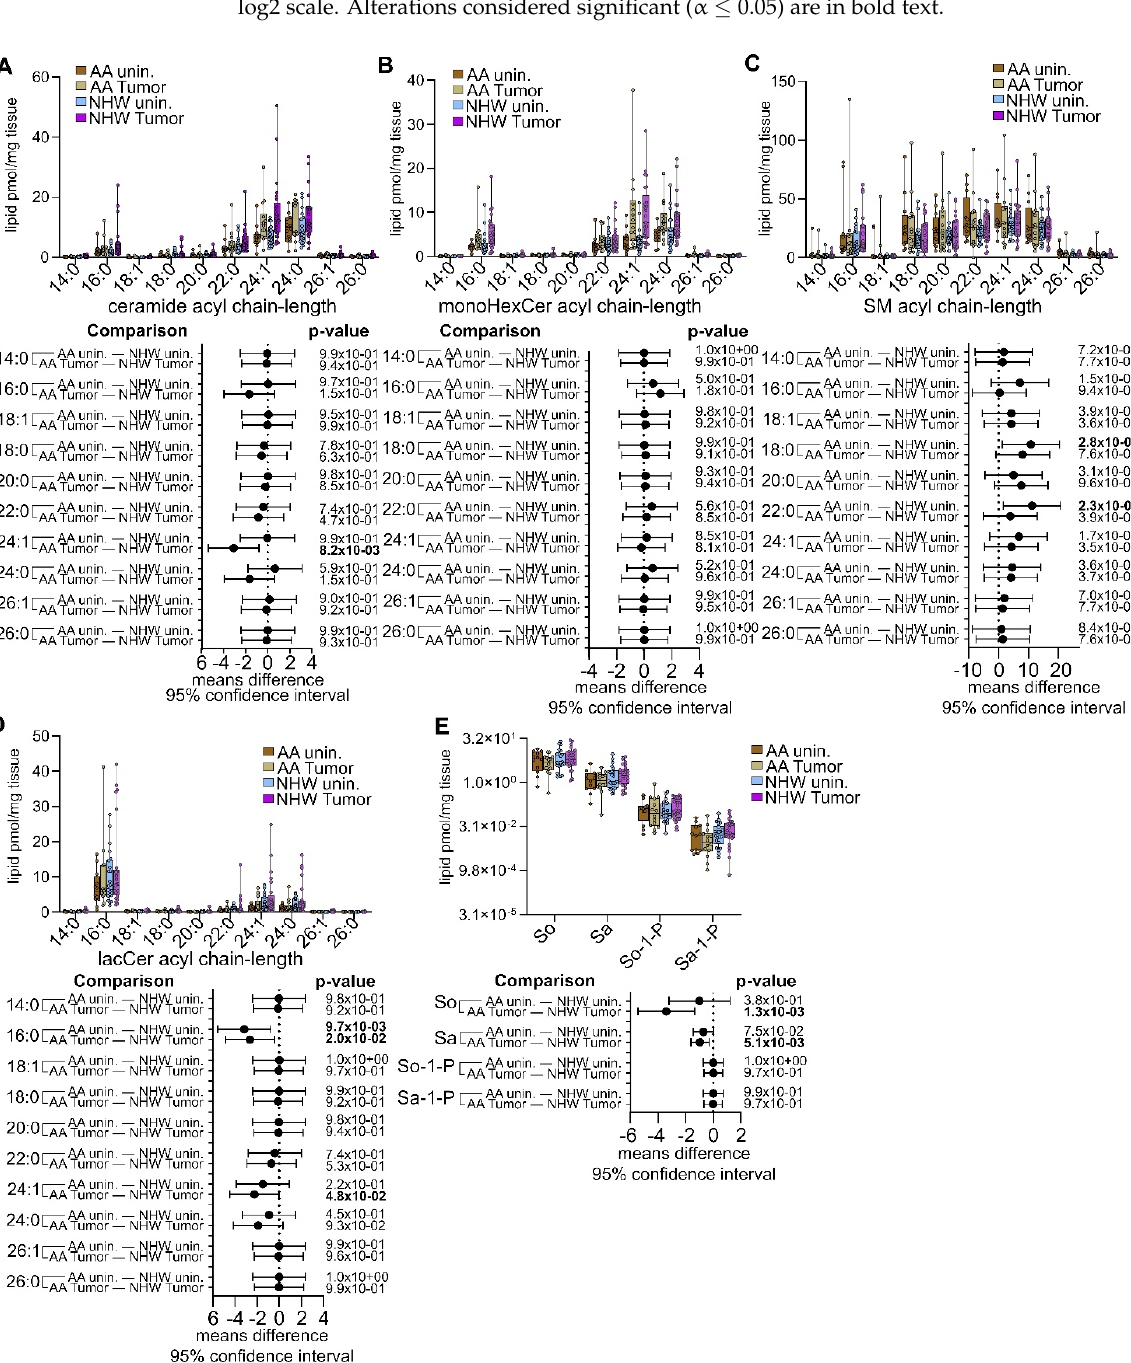
Figure 4. Secondary analysis comparisons of unin. vs. unin. and tumor vs. tumor sphingolipid profiles of self-identified AA and NHW males with LUAD. Data presented in Figures 2A–D,U and 3A–D,U were analyzed to examine differences in the indicated lipids between unin. and tumor tissues of AA and NHW with LUAD. In each panel ( A – E ), the upper graphs are box plots showing medians (black line) and whiskers of min to max (top), and the bottom graphs are plots of the 95% family-wise significance and confidence intervals for predicted means difference calculated following ANOVA. Corresponding unadjusted p -values (Fisher’s LSD; Prism) for the indicated comparisons are shown to the right of the 95% confidence interval plots. The lower limit of p - and q-value calcu- lations was set to 1.0 × 10 -15 (Prism), so no values are reported lower than this limit. For p -adjusted (q) values corrected for multiple comparisons using the FDR (Q = 0.05) and the two-step controlling procedure of BKY, see Supplementary Table S16. For panel ( E ), the y -axis is in log2 scale. Alterations considered significant ( α ≤ 0.05) are in bold text.